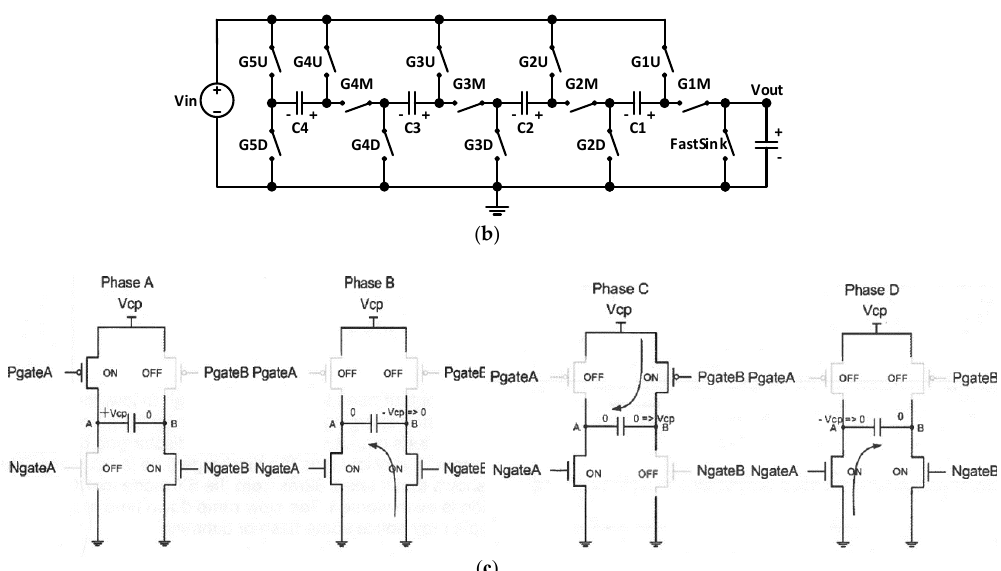
Figure 1. ( a ) System architecture of the LC driver; ( b ) Structure of the proposed multi-mode charge pump; ( c ) Switching scheme with a new low-power H-Bridge inverter.